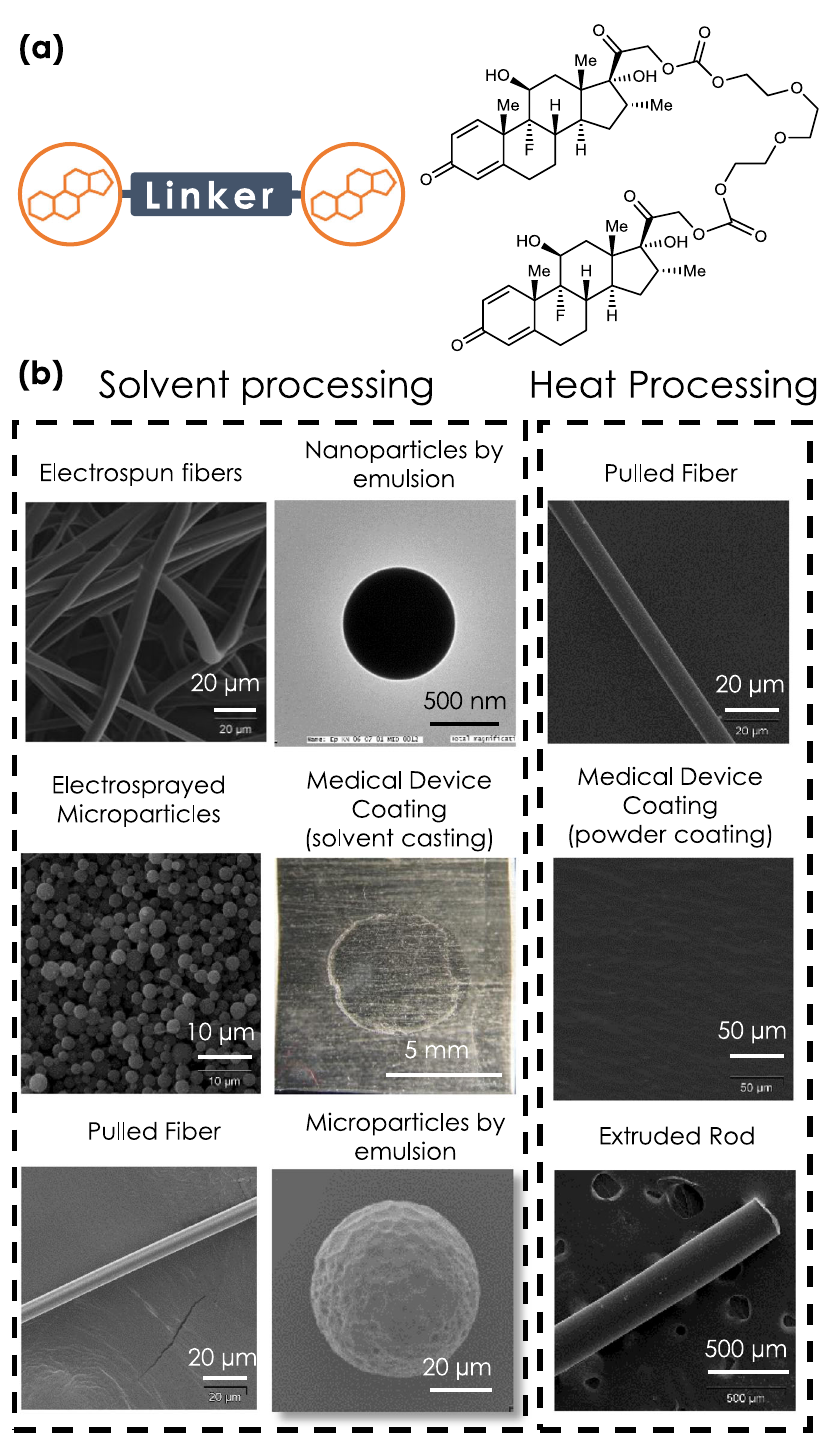
Fig. 1 Processing of drug dimers into stand-alone drug delivery vehicles. a Schematic demonstrating the general form of the dimers, and the chemical structure of a representative dimer molecule made with the corticosteroid dexamethasone using a triethylene glycol (TEG) linker. ( b Transmission electron microscopy (nanoparticles), light micrographs (coatings), and scanning electron microscopy (SEM) (all others) images demonstrating steroid dimers processed into different physical forms through thermal processing ( fi bers, coatings, extruded rods) and solvent processing (nanoparticles, microparticles, fi bers, coatings, fi brous